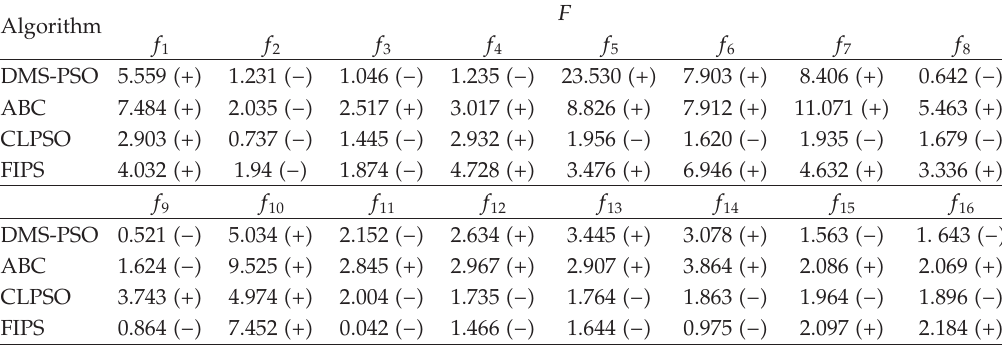
Table 6: DM-PSO-ABC di ff ers from other algorithms with bilateral t -testing method.